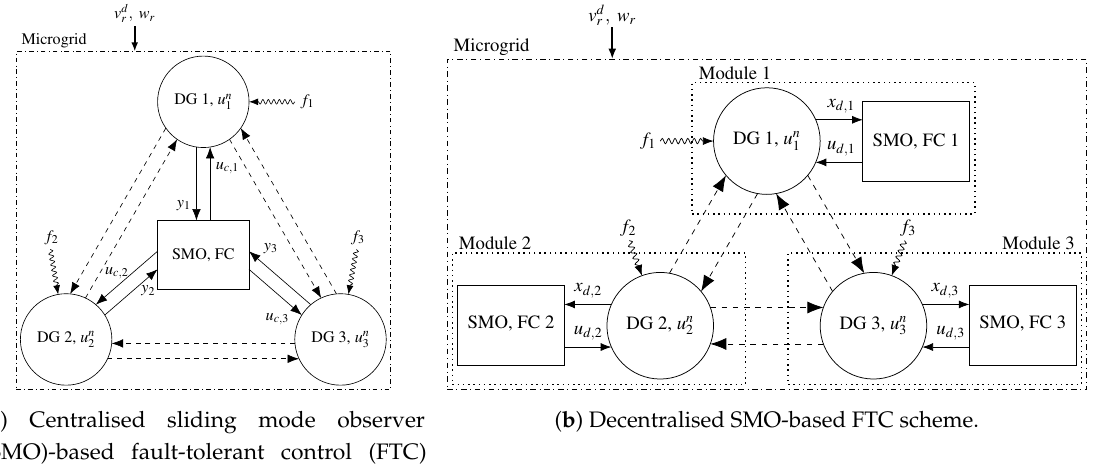
( a ) Centralised sliding mode observer ( b ) Decentralised SMO-based FTC scheme. (SMO)-based fault-tolerant control (FTC) Figure 1. The considered microgrid, using an example with three